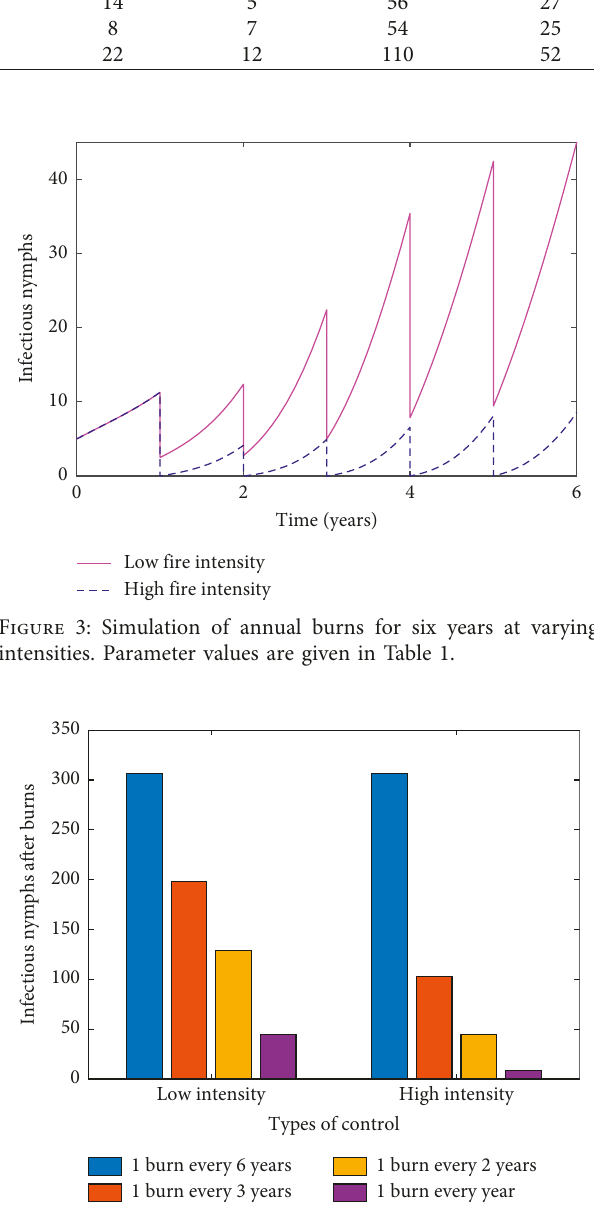
Table 2: Data taken from [21] under assumed high-intensity fire. C � control and B � burn. Larvae C